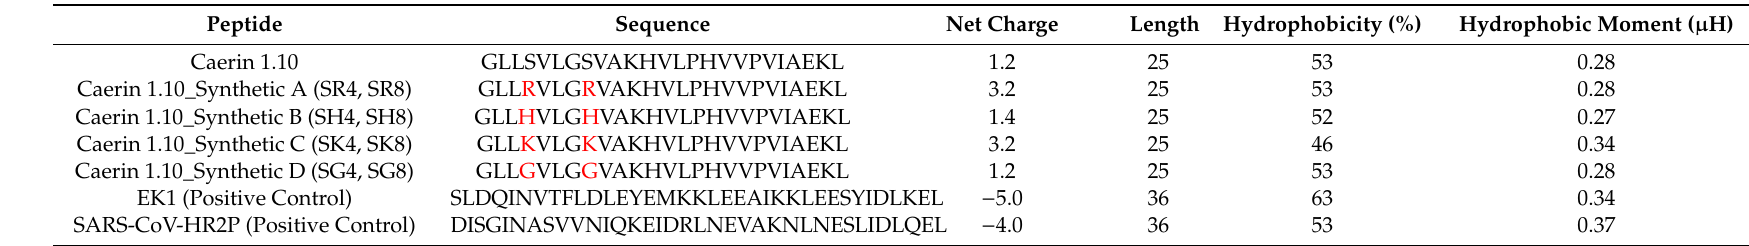
Table 7. Comparison of physicochemical parameters between control peptides and caerins. Residue changes in caerin 1.10 are highlighted in